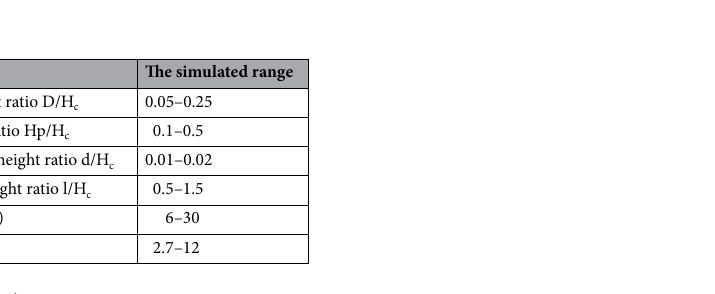
Table 2. Simulated parameters ranges.